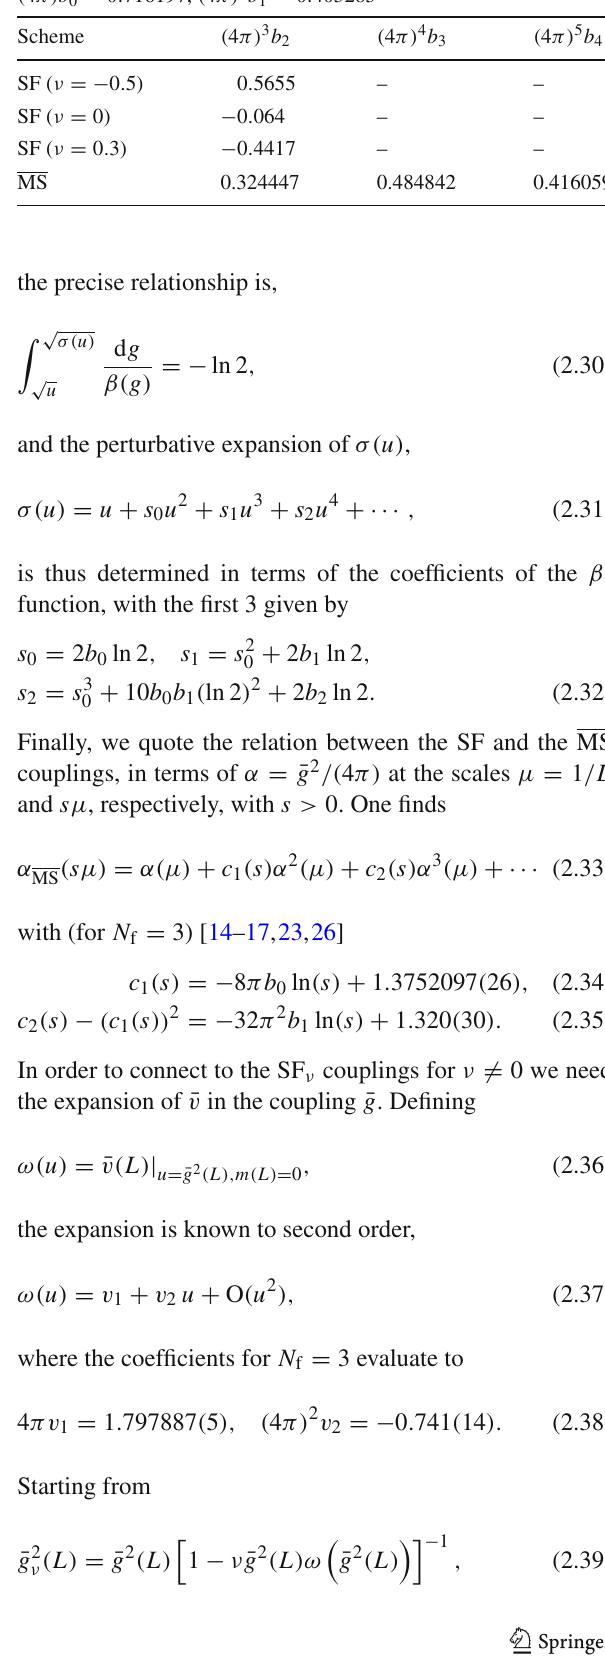
Table 1 Coefficients in the asymptotic expansion of the β -function